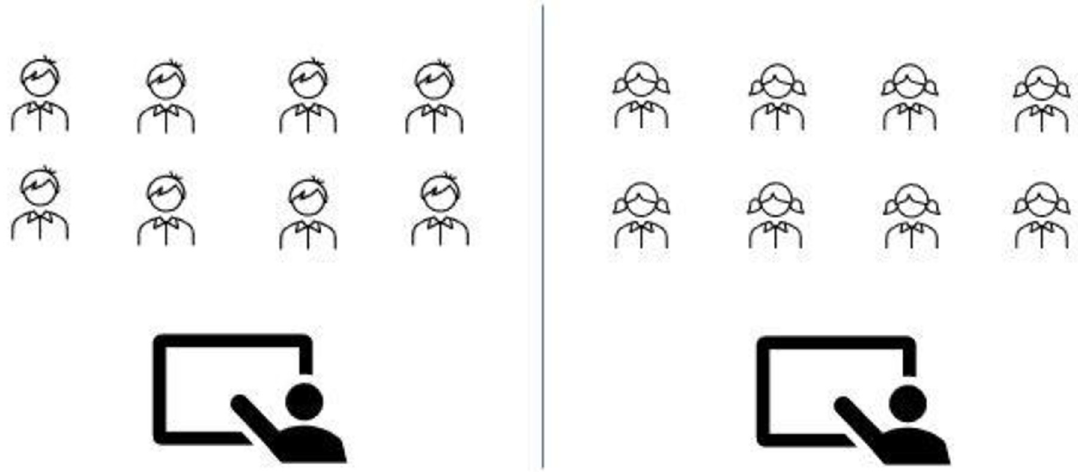
Fig 1. Single-gender traditional learning.